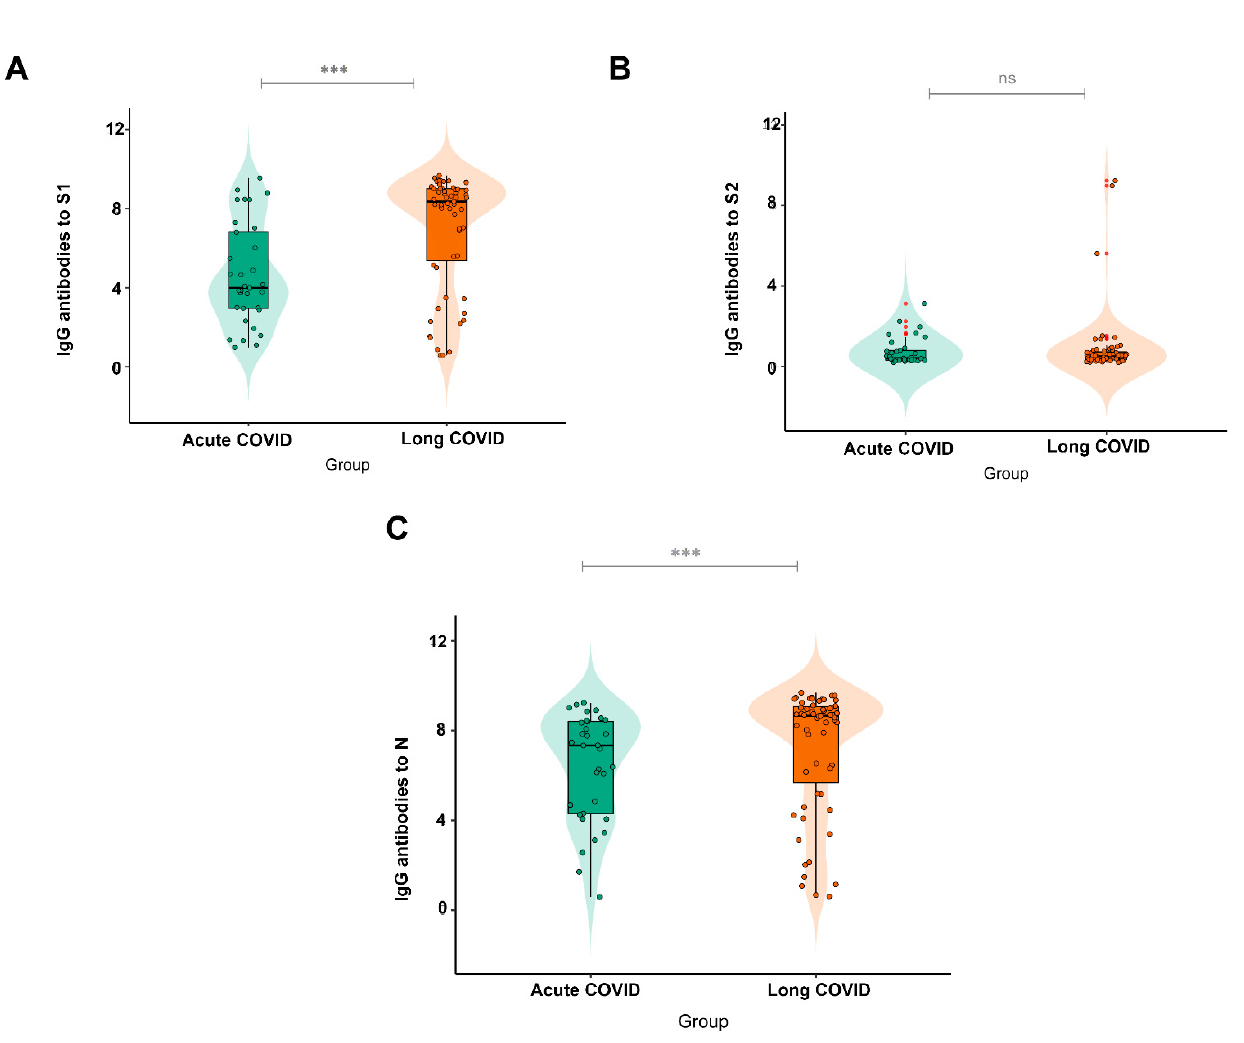
Figure 3. IgG antibody response to ( A ) (N = 56 Acute COVID; N = 30 Long COVID ) the S1 and ( B ) (N = 13 Acute COVID; N = 8 Long COVID ) S2 subunits and ( C ) (N = 59 Acute COVID; N = 31 Long COVID) the N protein in subjects with acute COVID-19 and long COVID-19. Significance value p < 0.0001 ***. ns: Non-significant.